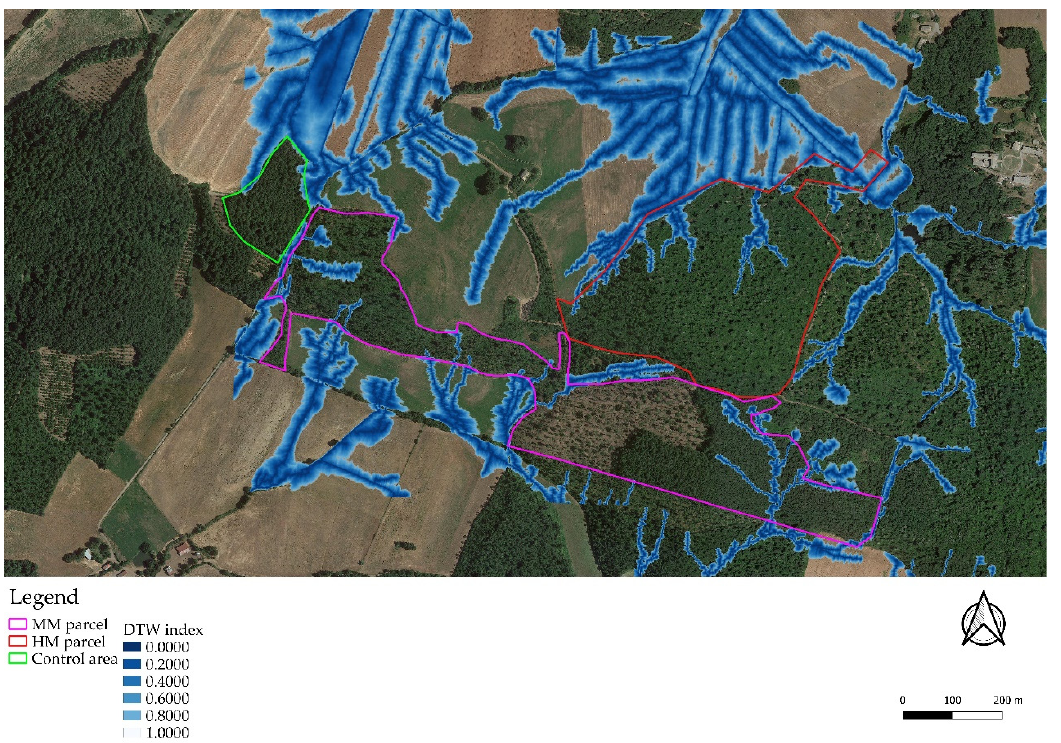
Figure 1. Google satellite image of the study area (date 7th July 2019). The boundaries of the two parcels are reported in purple (MM—medium mechanisation level) and red (HM—high mechanisation level). Control area is reported in green. Blu zones represent the areas in which DTW index is ≤ 1.